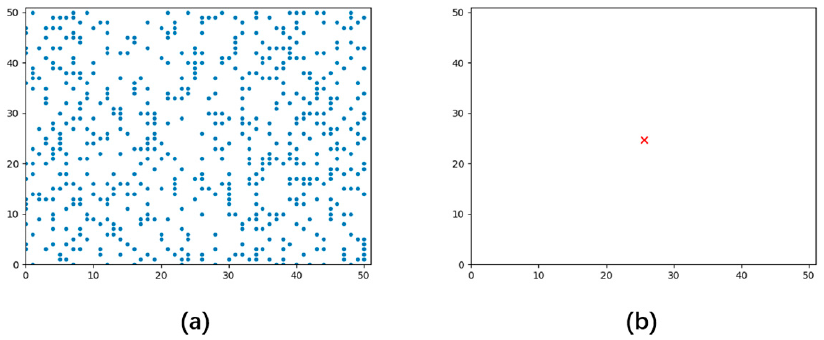
Figure 6. The clustering center of noise: ( a ) is a noise scatter diagram; ( b ) is a clustering center, which is the image center. According to the analysis in our study, there is a connected domain in the target area, but noise does not have this characteristic, so many randomly distributed unrelated points will be formed on the scatter plot. To minimize the impact of noise on the detection results, we removed isolated points from the scatterplot. We introduced the idea of an outlier removal method in point cloud data preprocessing. Points that do not have other points in the surrounding eight neighborhoods are defined as outliers. Figure 7 is a schematic of the outliers.